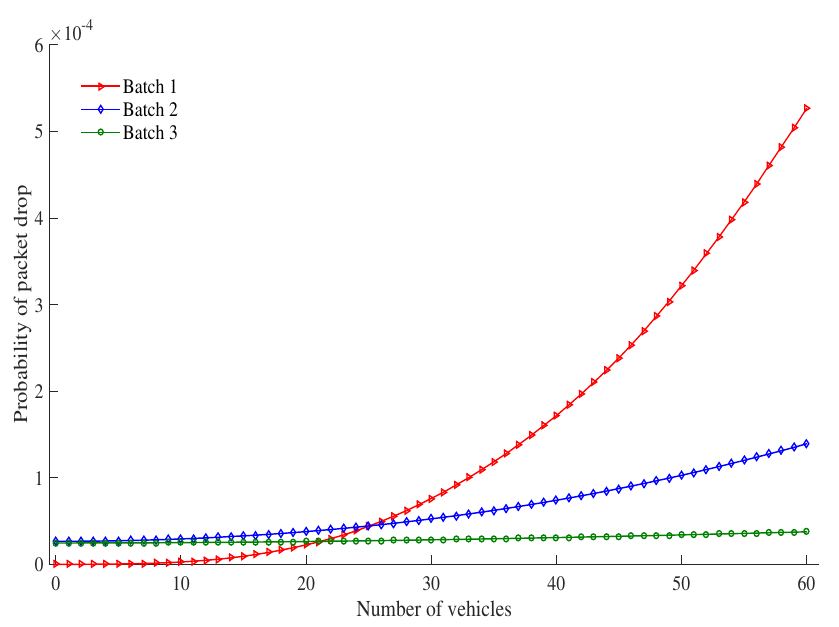
Figure 8. Probability of collision vs. number of vehicles.